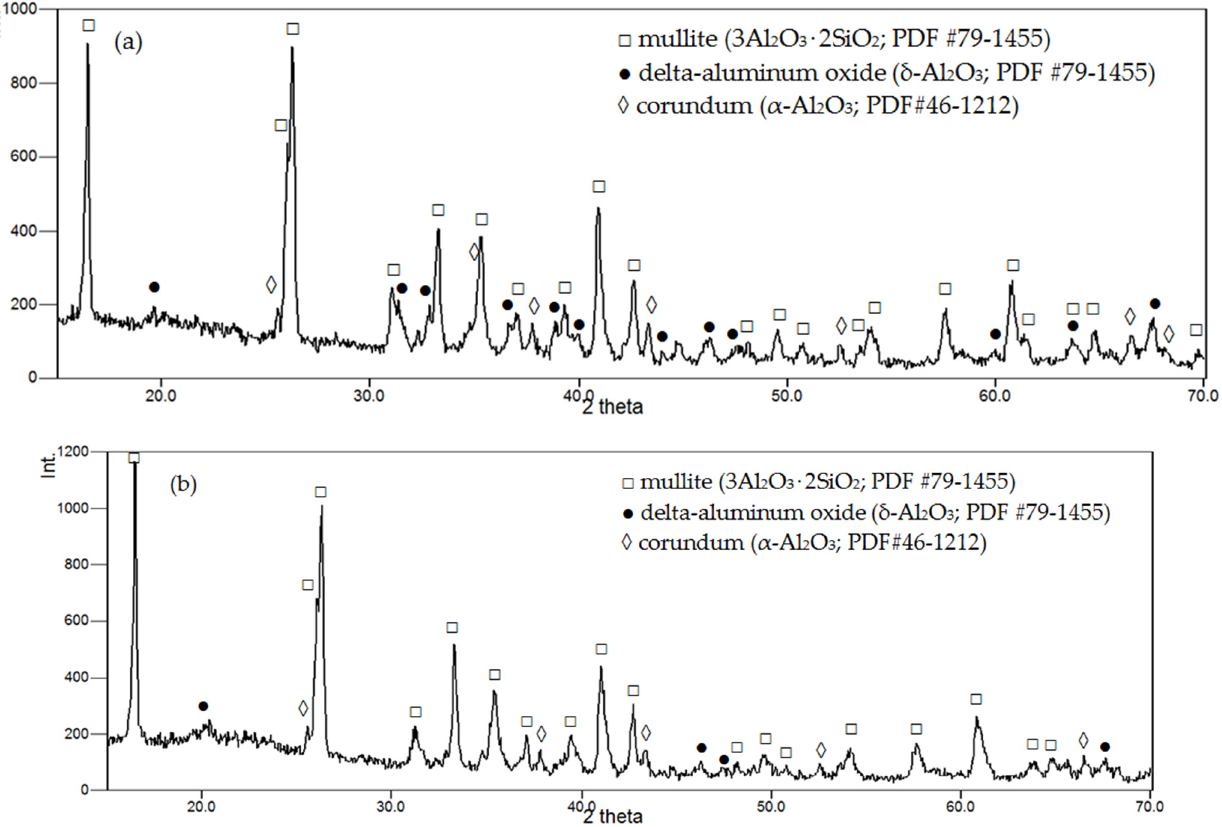
Figure 5. The diffraction pattern of the material I after heating to 1600 °C with concentrated solar radiation: the specimen from the “hot” side of the sample treated in the first mode ( a ); the specimen from the “cold” side of the sample treated in the first mode ( b ).